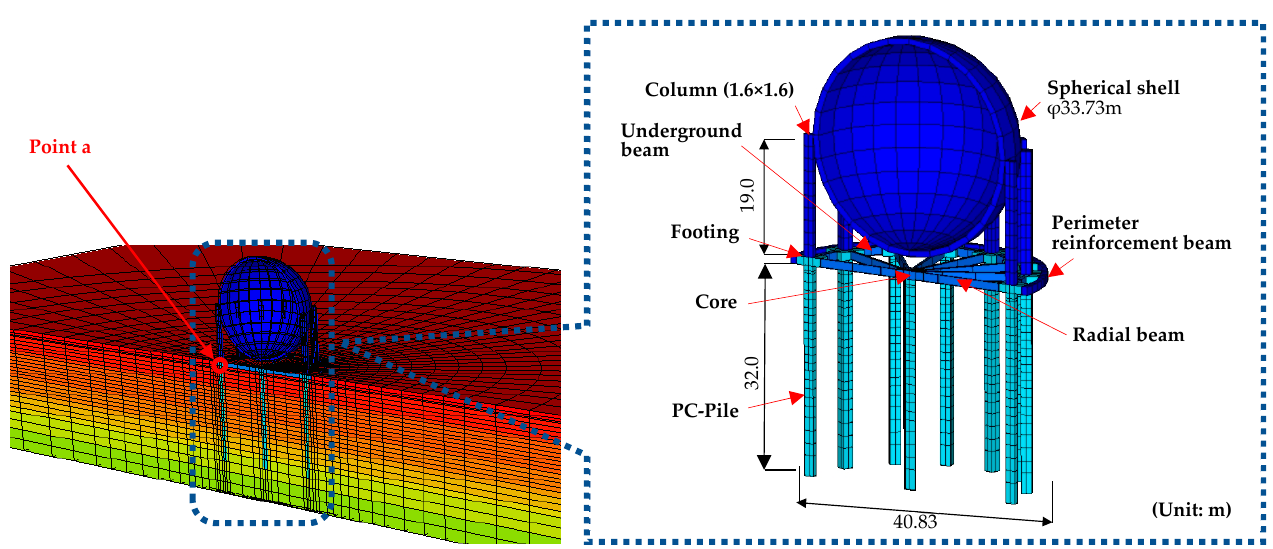
Figure 7. Analysis model.